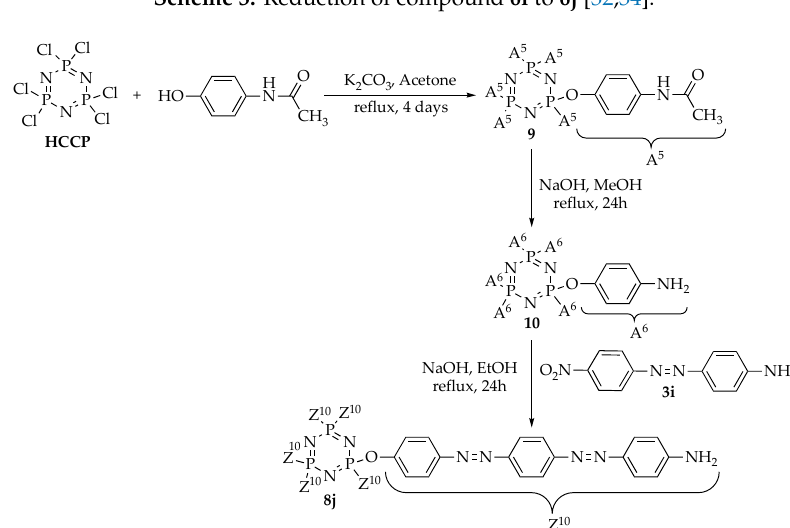
Scheme 4. Formation of disk-like intermediates ( 9 and 10 ) and compound 8j [37,40].